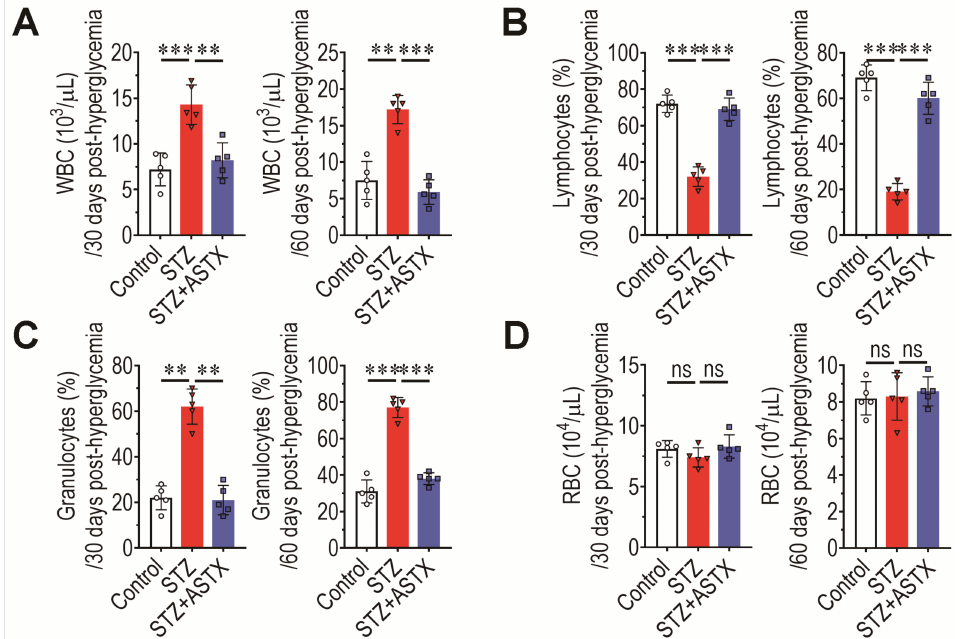
Figure 6. Oral gavage of ASTX restores normal production of circulating blood cells in STZ-injected mice. Levels of circulating ( A ) WBCs, ( B ) lymphocytes, ( C ) granulocytes, and ( D ) RBCs in mouse groups were measured using an automated complete blood cell counter at 30 and 60 days after hyperglycemia induction ( n = 5/group). ** p < 0.01 and *** p < 0.001 by unpaired Student’s t -test. ns, not